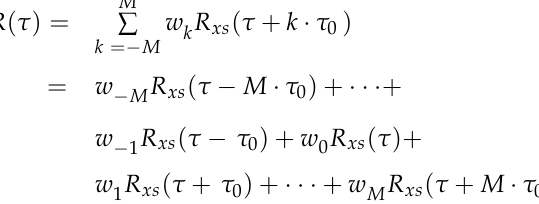
e − j ω 0 n , where ω c is the π n